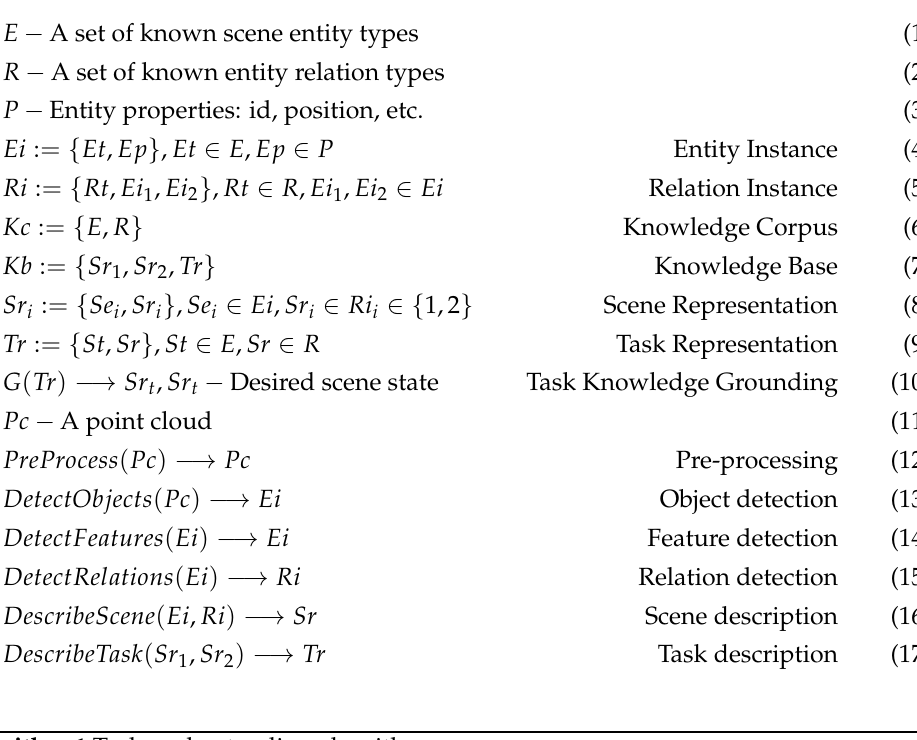
Algorithm 1 Task understanding